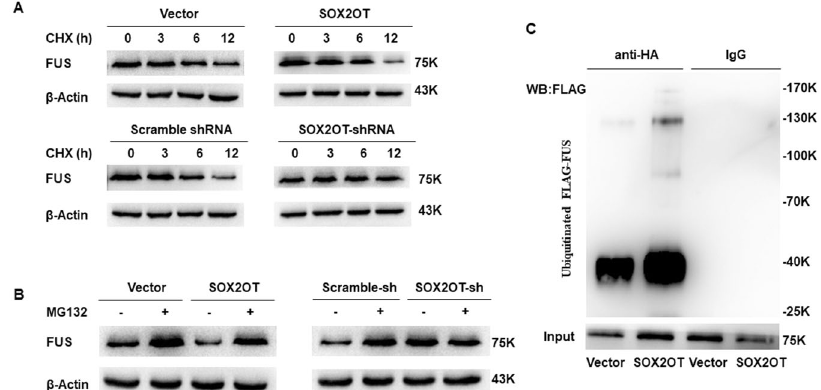
Fig. 4 SOX2OT promotes the ubiquitination and degradation of FUS protein. A Cells were treated with the protein synthesis inhibitor CHX, and the remaining of FUS protein was measured by western blot at 0, 3, 6, and 12 h. B Western blot analysis of FUS in the SOX2OT overexpression or SOX2OT knockdown cells treated with MG132 ( + ) or DMSO ( – ) for 6 h. C The SOX2OT overexpression cells were cotransfected with a plasmid expressing a HA-tagged ubiquitin (HA-Ub) and a plasmid expressing a FLAG-tagged FUS (FLAG-FUS). After MG132 treatment, cell lysates were prepared and subjected to IP using an anti-HA antibody. The ubiquitinated FLAG-FUS was further detected by western blot using an anti-FLAG